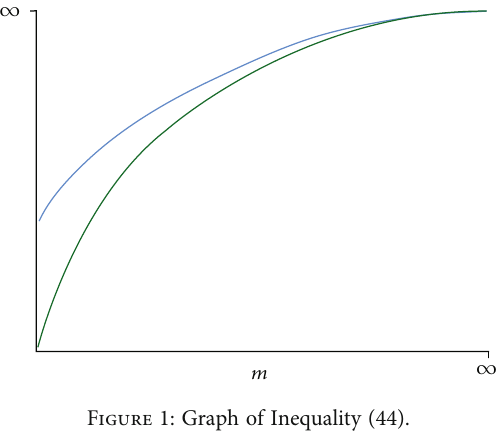
Figure 1: Graph of Inequality